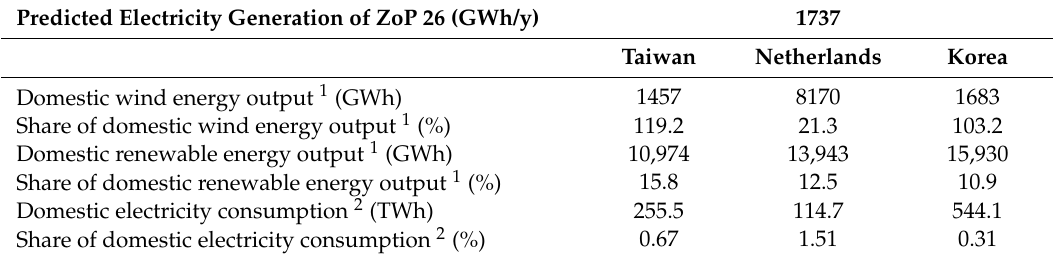
Table 12. Comparative efficiency of wind farm ZoP 26 for selected countries in 2016. Predicted Electricity Generation of ZoP 26